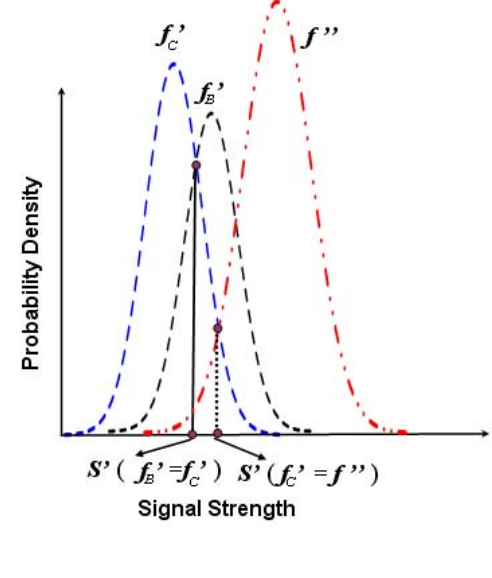
Figure 6. Probability density functions of signal strength received from three beacon